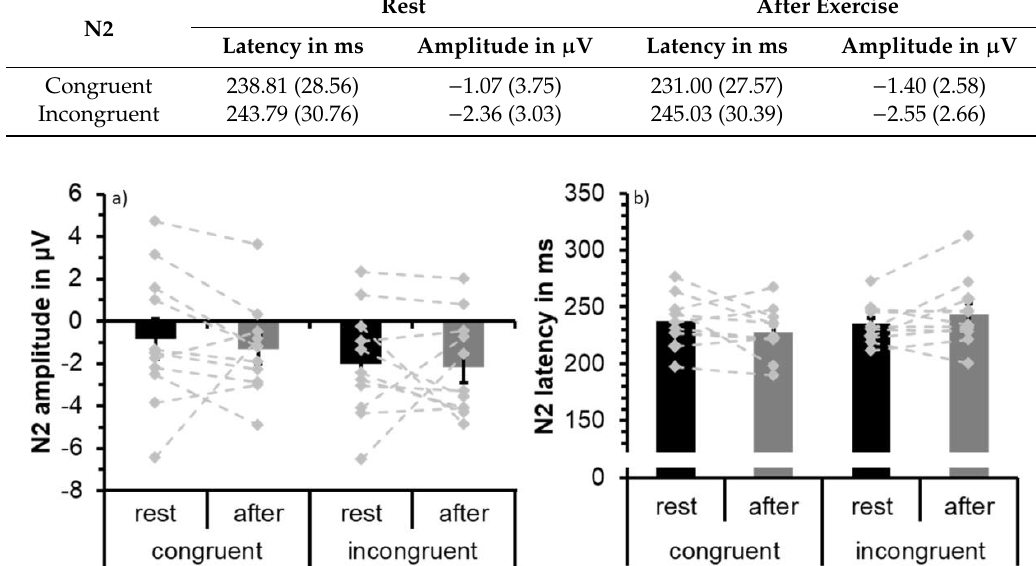
Figure 4. Mean N2 peak amplitude ( a ) and peak latency ( b ) averaged across participants ( N = 11) and across fronto-central electrode sites (F3, Fz, F4, FC1, FC2, Cz) to congruent and incongruent trials at rest (black) and following acute exercise at moderate intensity (grey). Error bars depict standard error values. The DotPlot visualizes the individual data (light grey) for the congruent and incongruent condition as well as the change from rest to after-exercise (dashed lines).